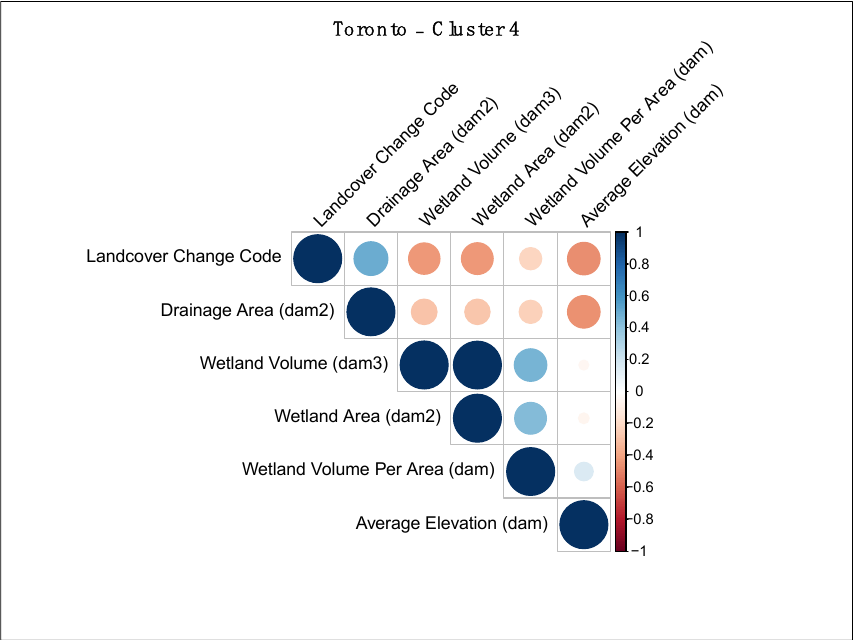
Figure 5. Toronto cluster 4 correlation matrix.